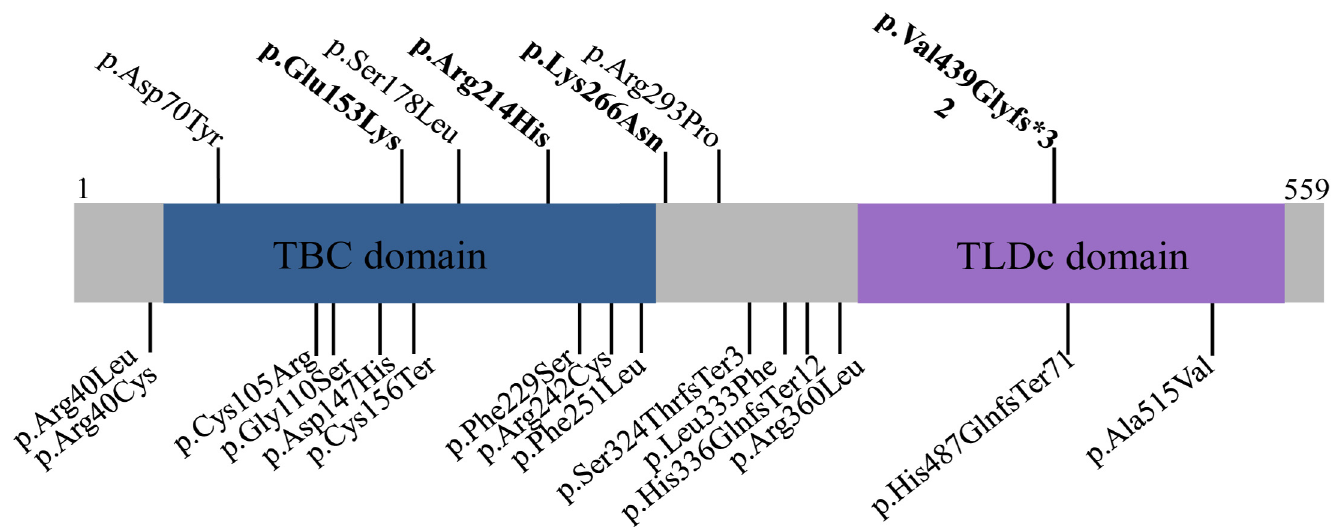
Fig 2. Schematic representation of the mutations responsible for non-syndromic hearing loss, in the TBC1D24 protein. The TDC and TLBc functional domains are represented on the TBC1D24 protein structure. The amino-acid changes identified in this work (in bold) and the published recessive and dominant mutations responsible for NHSL are shown on the top, while mutations responsible for DOORS syndrome, familial infantile myoclonic epilepsy, progressive myoclonus epilepsy and early-infantile epileptic encephalopathy-16 are shown below the protein